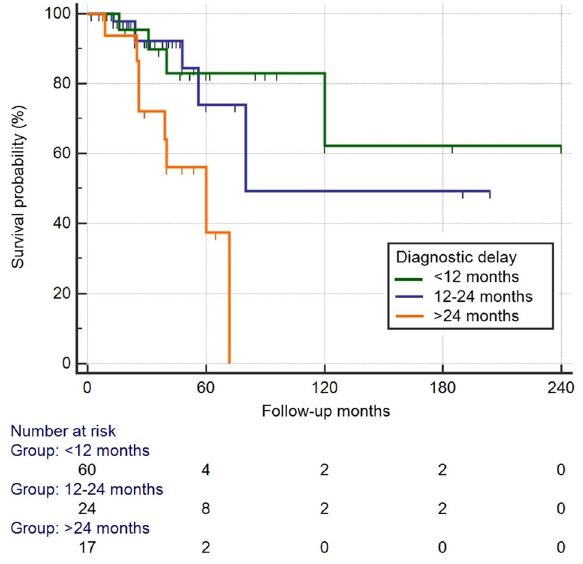
Figure 4. Kaplan–Meier survival curves for patients with RA-ILD. Overall survival according for diagnostic delay (Log Rank Test: p =